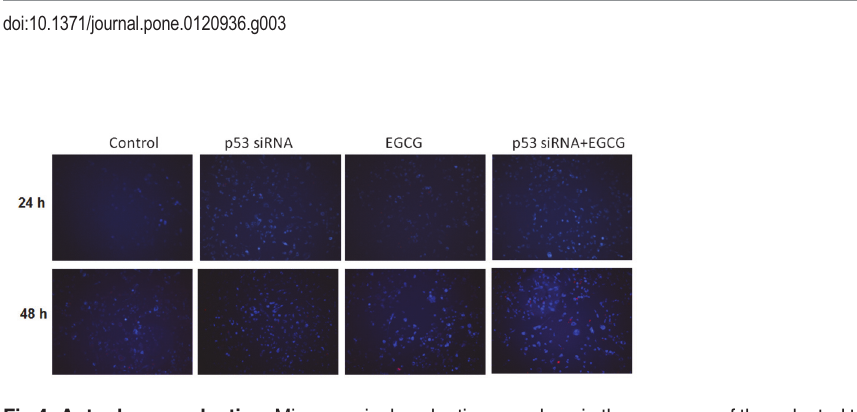
Fig 4. Autophagy evaluation. Microscopical evaluation was done in the presence of the selected treatment scenarios at 24 and 48 h post-treatment in Hs578T cell line.